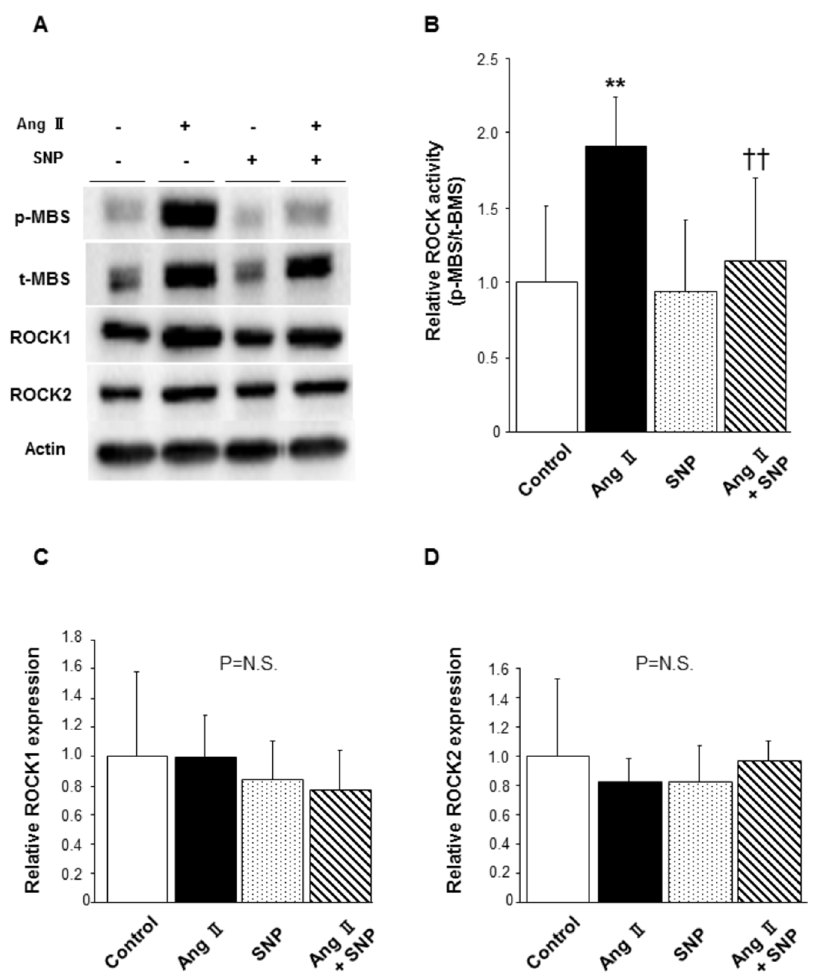
Figure 4. Effect of SNP on Ang II-induced ROCK activation in mouse aortas. Mice were treated with saline or Ang II via implanted micro- osmotic pump infusion (2 mg/kg/day) and treated with saline or SNP via subcutaneous injection (5 mg/kg once a day) for 14 days. Increased blood pressures in Ang II-treated mice were normalized to levels similar to those in mice without Ang II treatment by hydralazine included in drinking water (20 mg/kg/day). (A) Representative results of Western blot analysis for p-MBS, t-MBS, ROCK1, ROCK2, and actin. (B) Quantitative analysis of relative ROCK activity (p-MBS/t-MBS). (C) Quantitative analysis of relative ROCK1 expression. (D) Quantitative analysis of relative ROCK2 expression. n=5–11 in each group; **P , 0.01 compared to control; {{ P , 0.01 compared to Ang